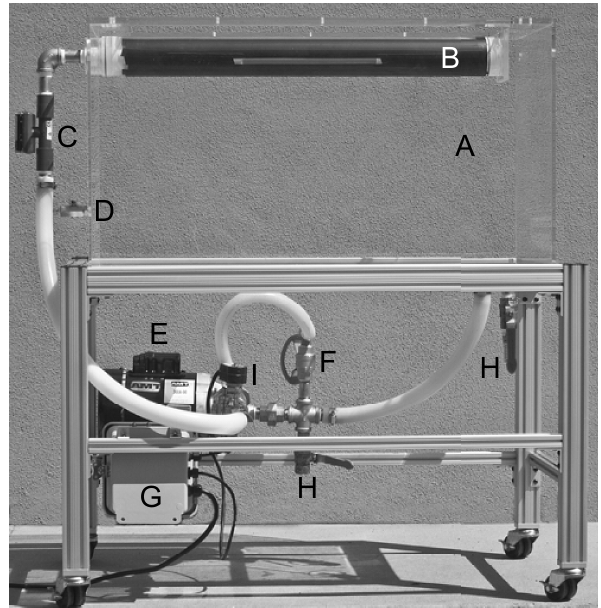
Fig. 2. Marine Aerosol Reference Tank (MART). The 210L plex- iglass tank (A) is approximately 1m in the longest dimension. (B) The internal water distribution assembly is o-ring sealed with central spillway slot. Inside the assembly is a secondary diffuser tube (not visible) for evenly distributing the water along the spill- way. (C) Flow meter. (D) Tank water sampling spigot. (E) 1 / 3 HP Centrifugal pump. (F) Flow shunt control valve. (G) Timing relay control box. (H) Tank drain and purge valves. (I) Solenoid valve.